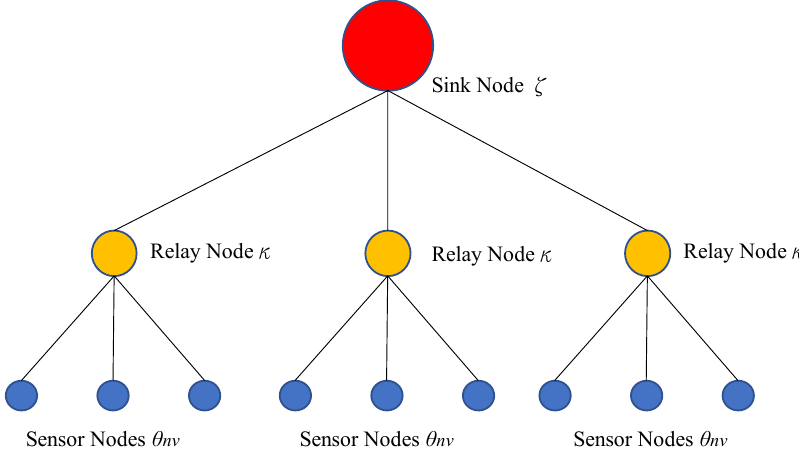
Figure 2. Tree Structure Model of WSN.